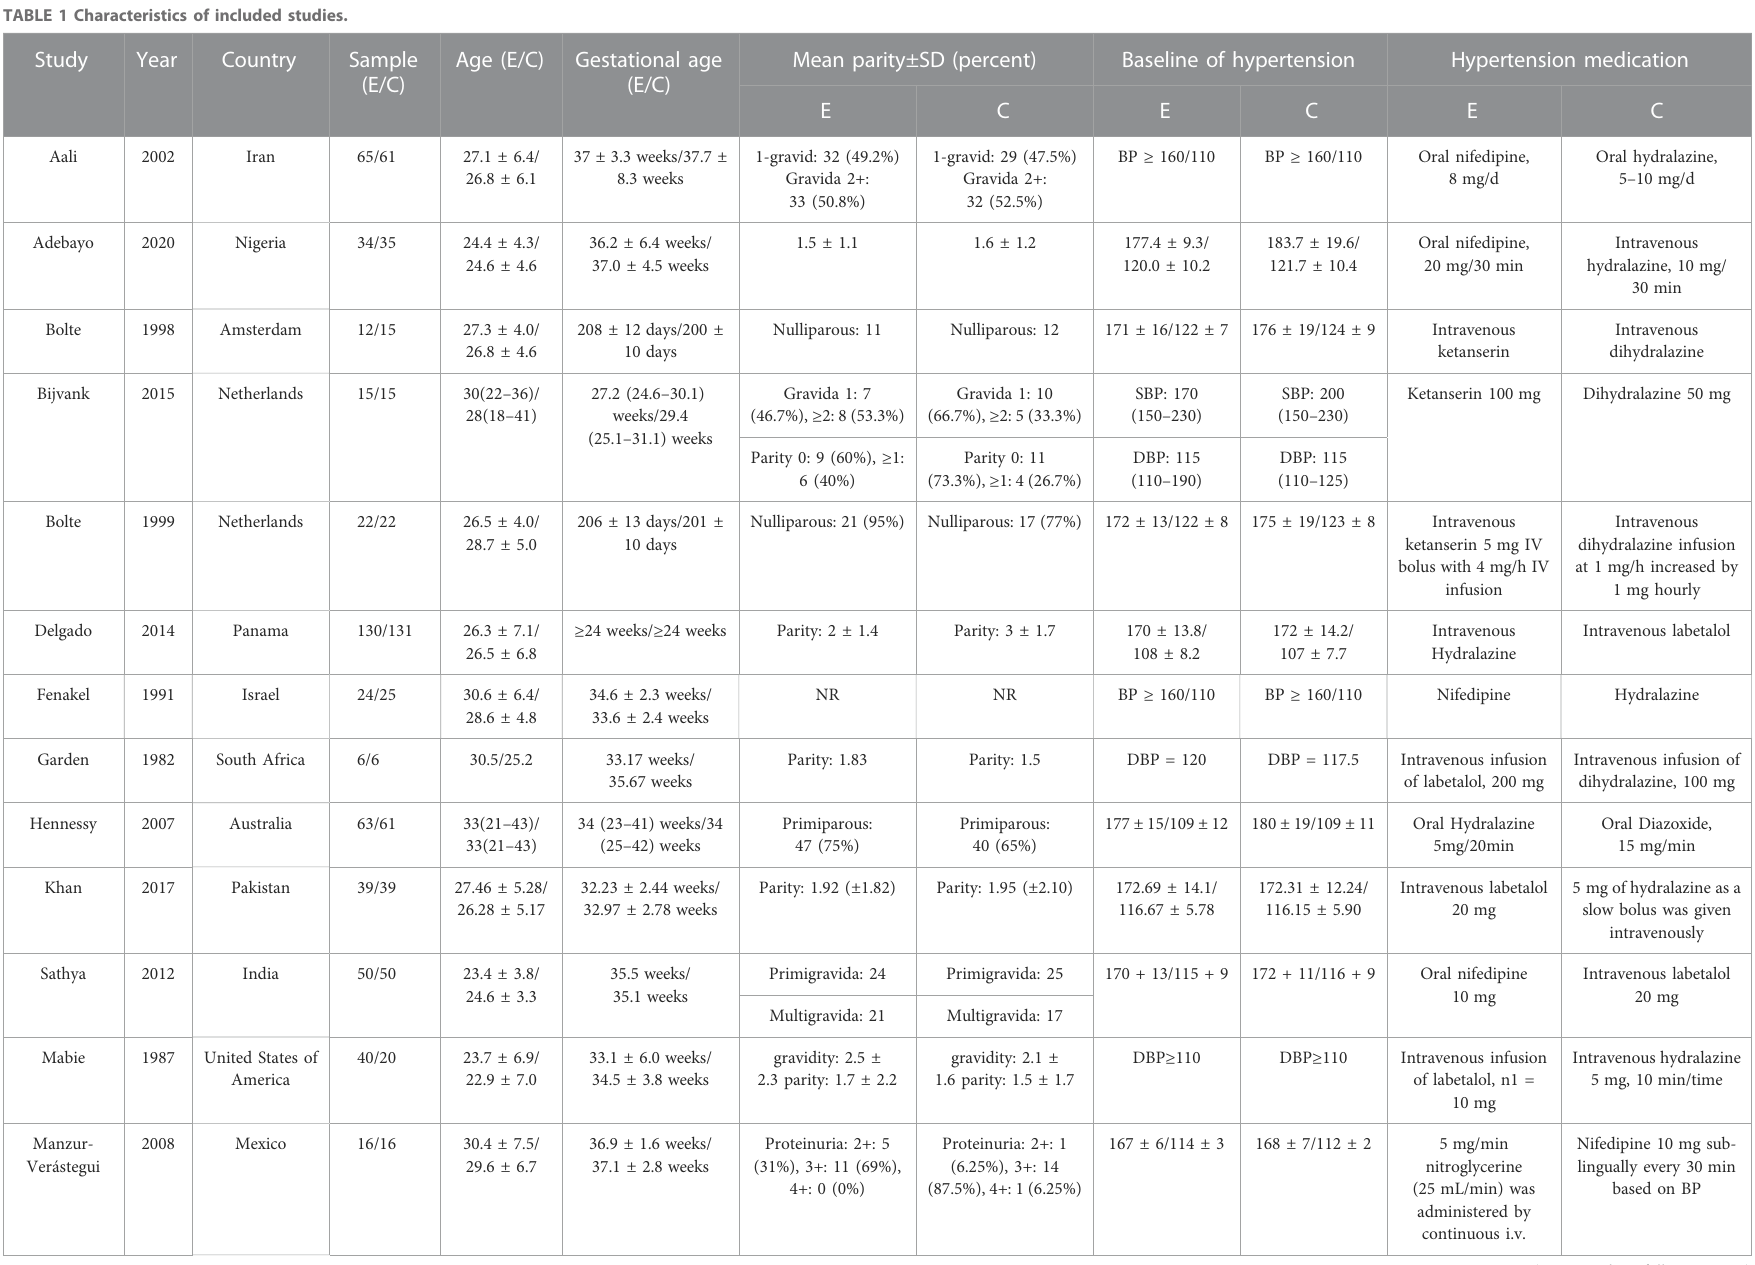
TABLE 1 Characteristics of included